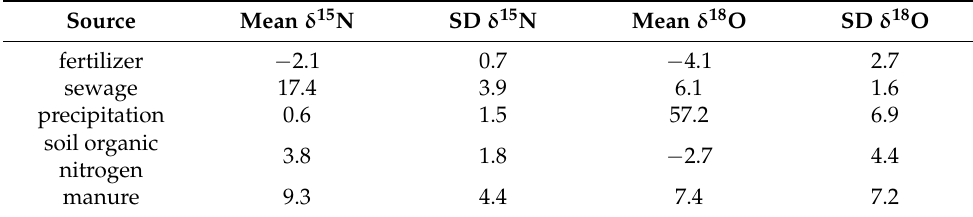
Table 1. δ 15 N-NO 3 − and δ 18 O-NO 3 − values of potential NO 3 − sources in surface